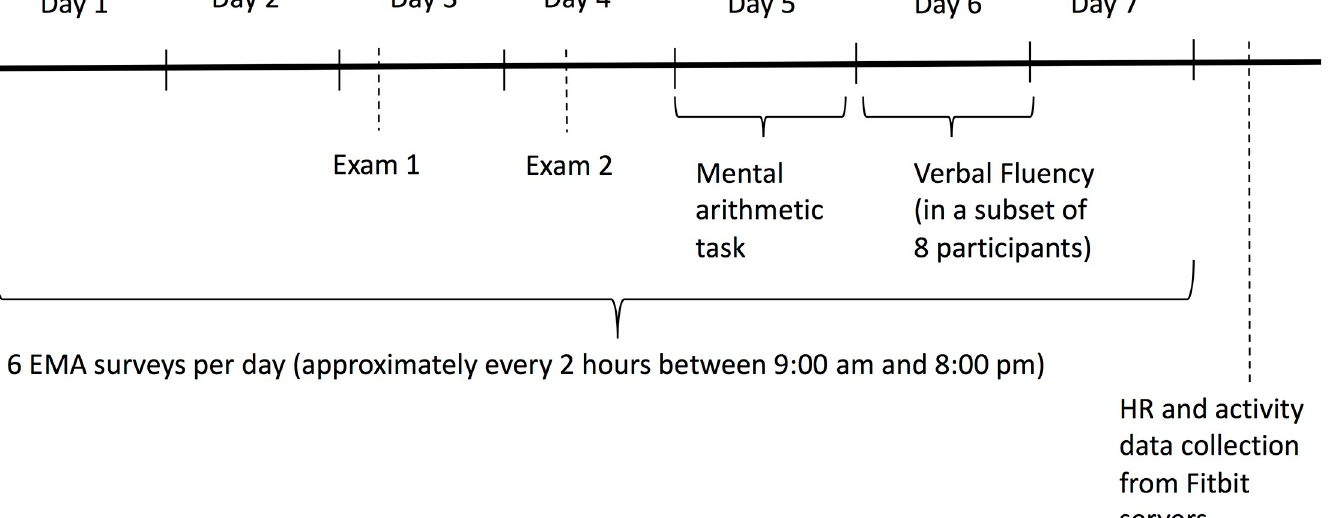
PLOS ONE | https://doi.org/10.1371/journal.pone.0229942 March 25,